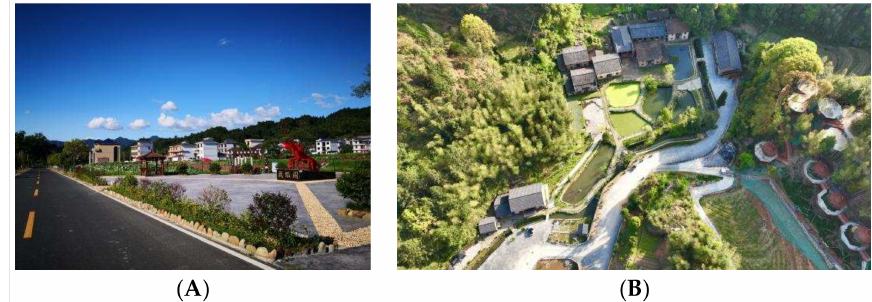
Figure 3. ( A ) Shrimp breeding base. ( B ) A tourist village with lots of